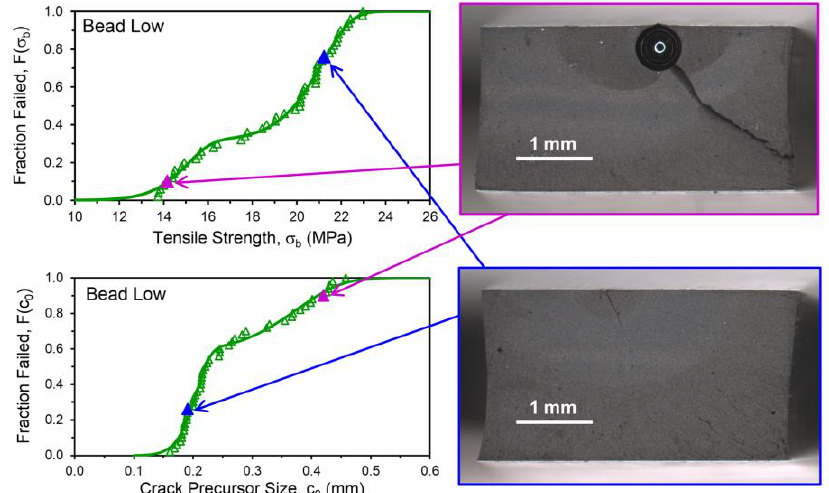
Figure 9. Tensile specimen fracture surfaces for two representative replicates of the Bead Low compound along with indications of their σ b and c 0 values in the distributions. The fracture of the specimen with the lower σ b and higher c 0 was clearly initiated by the presence of a glass microsphere (upper right image).